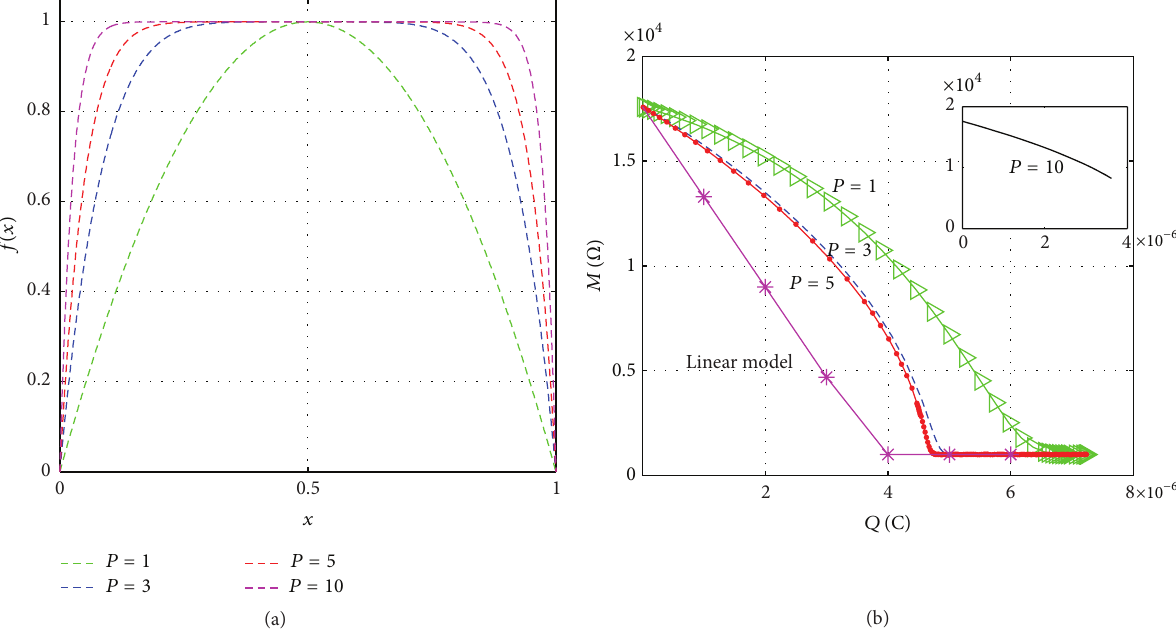
Figure 2: The influence of different values of the integer 𝑃 on the memristor. (a) Joglekar window function for 𝑃 = 1 , 𝑃 = 3 , 𝑃 = 5 , and 𝑃 = 10 . (b) Relationship between memristance versus charge for the nonlinear memristor model. As the integer 𝑃 increases, the graphs tend to